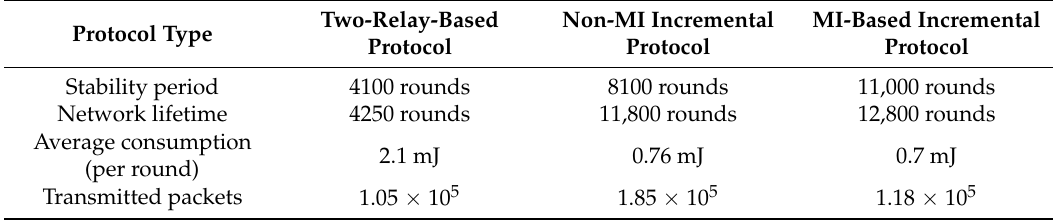
Table 2. Simulation results of the proposed three communication